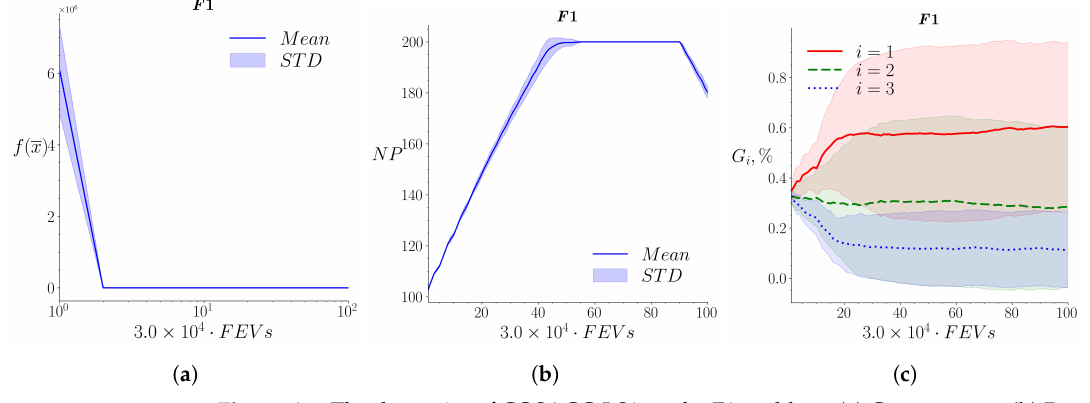
Figure A1. The dynamics of COSACC-LS1 on the F1 problem: ( a ) Convergence; ( b ) Population size; ( c ) Redistribution of